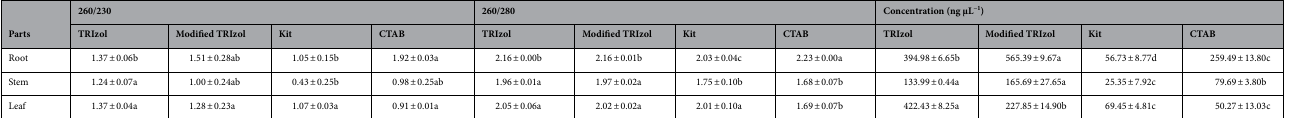
Table 1. Average purity and yield of total RNA extracted from root, stem and leaf of Lilium davidii var. unicolor using different